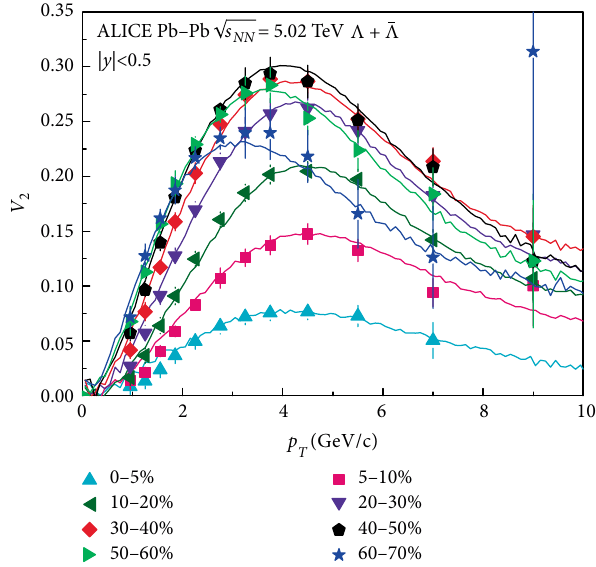
Figure 4: As for Figure 1, but showing 𝑣 centrality [36].